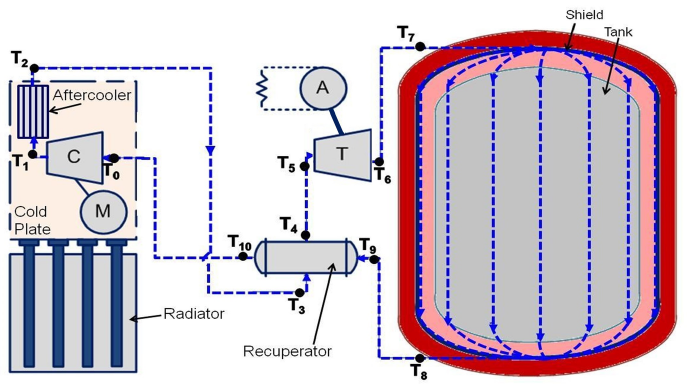
Figure 14. Cryocooler system schematic. Adapted from Guzik and Tomsik [24]. Using the information found in the analysis by Plachta et al. and in Guzik and Tomsik [23,24], IBDs representing the different flows between the components were created. The IBDs of the two stage and one stage thermal management system can be seen in Figures 15 and 16, respectively. Both systems show the different flows of working fluid and heat exchanges with the major difference being that the two stage system has an additional cryocooler system extracting heat from the outer MLI. All cryocooler systems are assumed to share the same architecture depicted in Figure 17.